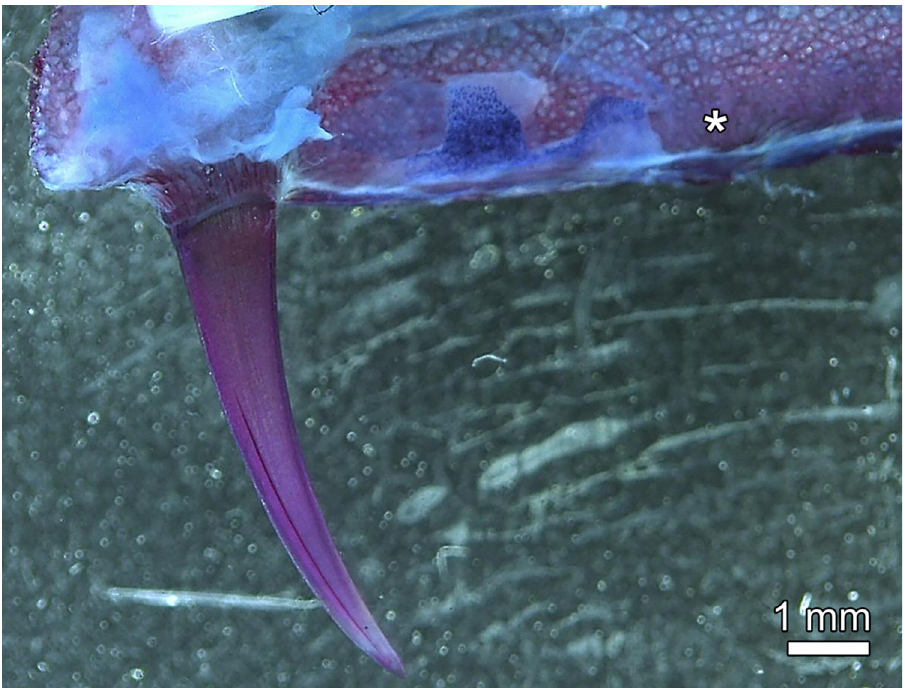
Fig 3. Anterior portion of right premaxilla of Anoplogaster cornuta , cleared and stained (Alizarin red S, alcian blue 8 GX) specimen, medial view. No replacement tooth is present at the empty locus (asterisk) of the second premaxillary